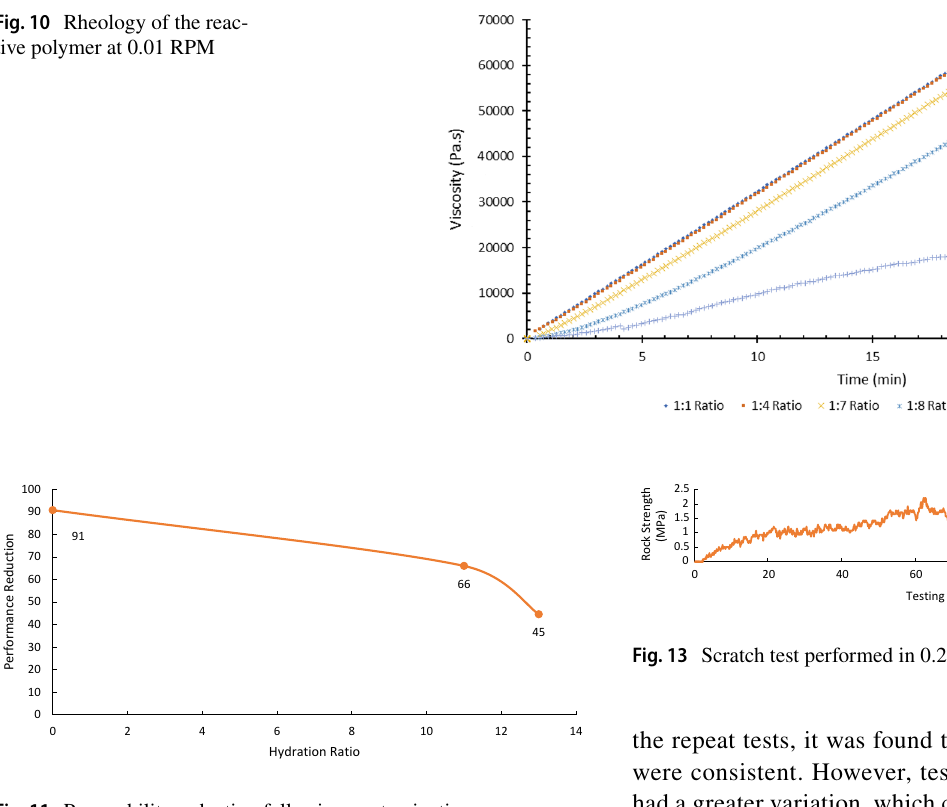
Fig. 11 Permeability reduction following contamination